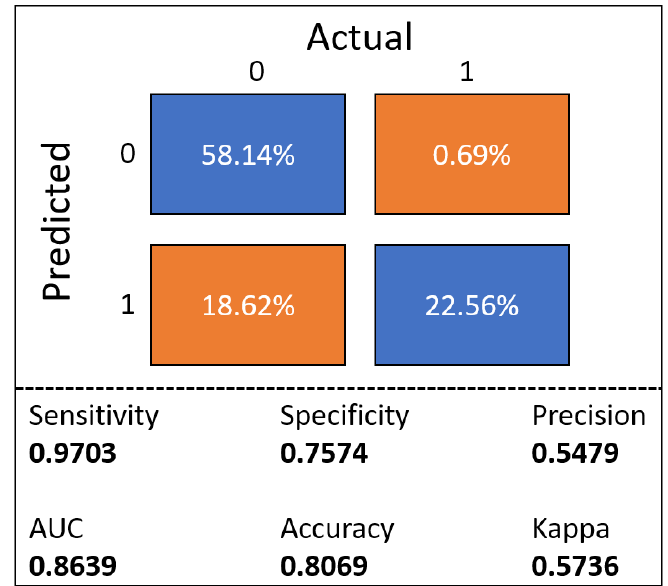
Figure 10. CNN Confusion matrix for the blind